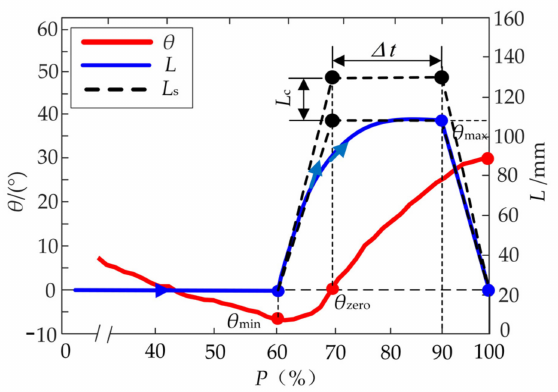
Figure 5. Desired displacement L